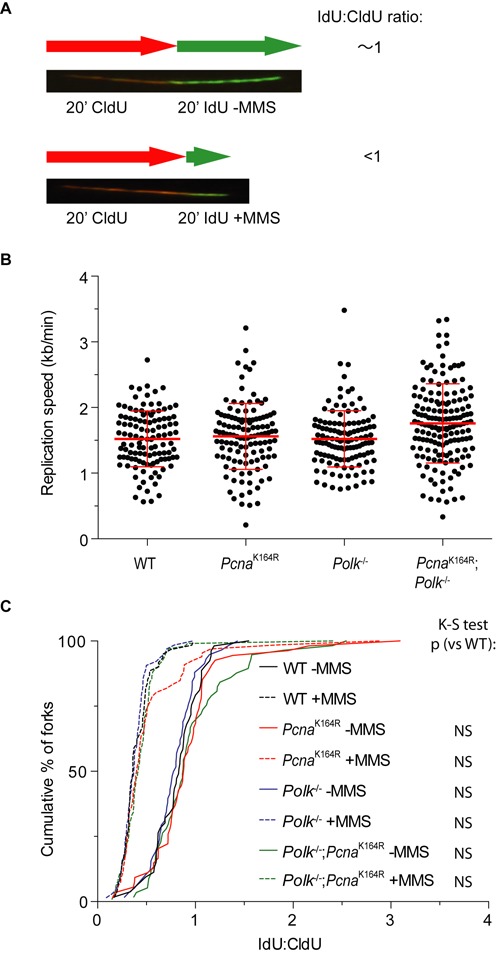
Replication fork progression analysis after MMS treatment. (A) Scheme of DNA fiber analysis experiment. MEFs were first labeled with 25 μM CldU for 20 min and then 20 min with 250 μM IdU, or 250 μM IdU and 3 mM MMS. The length of CldU and IdU tracks was measured and the average replication speed (kb/min, error bars represent SD) on a non-damaged template of the CldU track was calculated (B). (C) Analysis of IdU:CldU ratios of mock and MMS-treated WT, Polk−/−, PcnaK164R and Polk−/−; PcnaK164R MEFs. Data are presented as cumulative percentage of forks at each ratio. At least 50 DNA fibers were analyzed per experiment. A representative experiment is shown (of 2). The Kolmogorov–Smirnov (K-S) test was performed to determine statistical significance. NS means not significant. None of the tested genotypes show a significant difference (K-S test, p > 0.05) compared to wild-type cells.